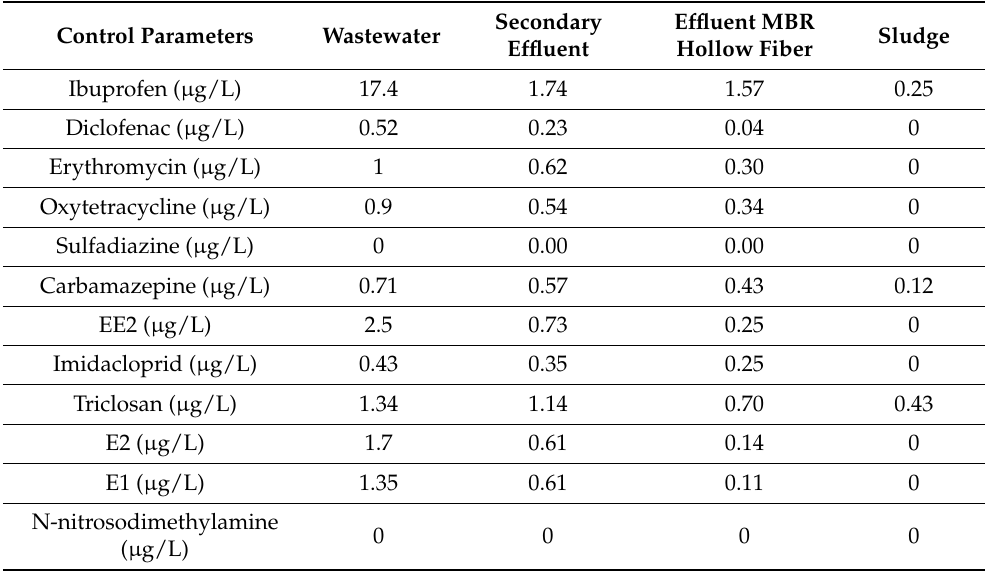
Table 6. Average concentrations of the emerging pollutants selected as a model for monitoring at WWTP B.